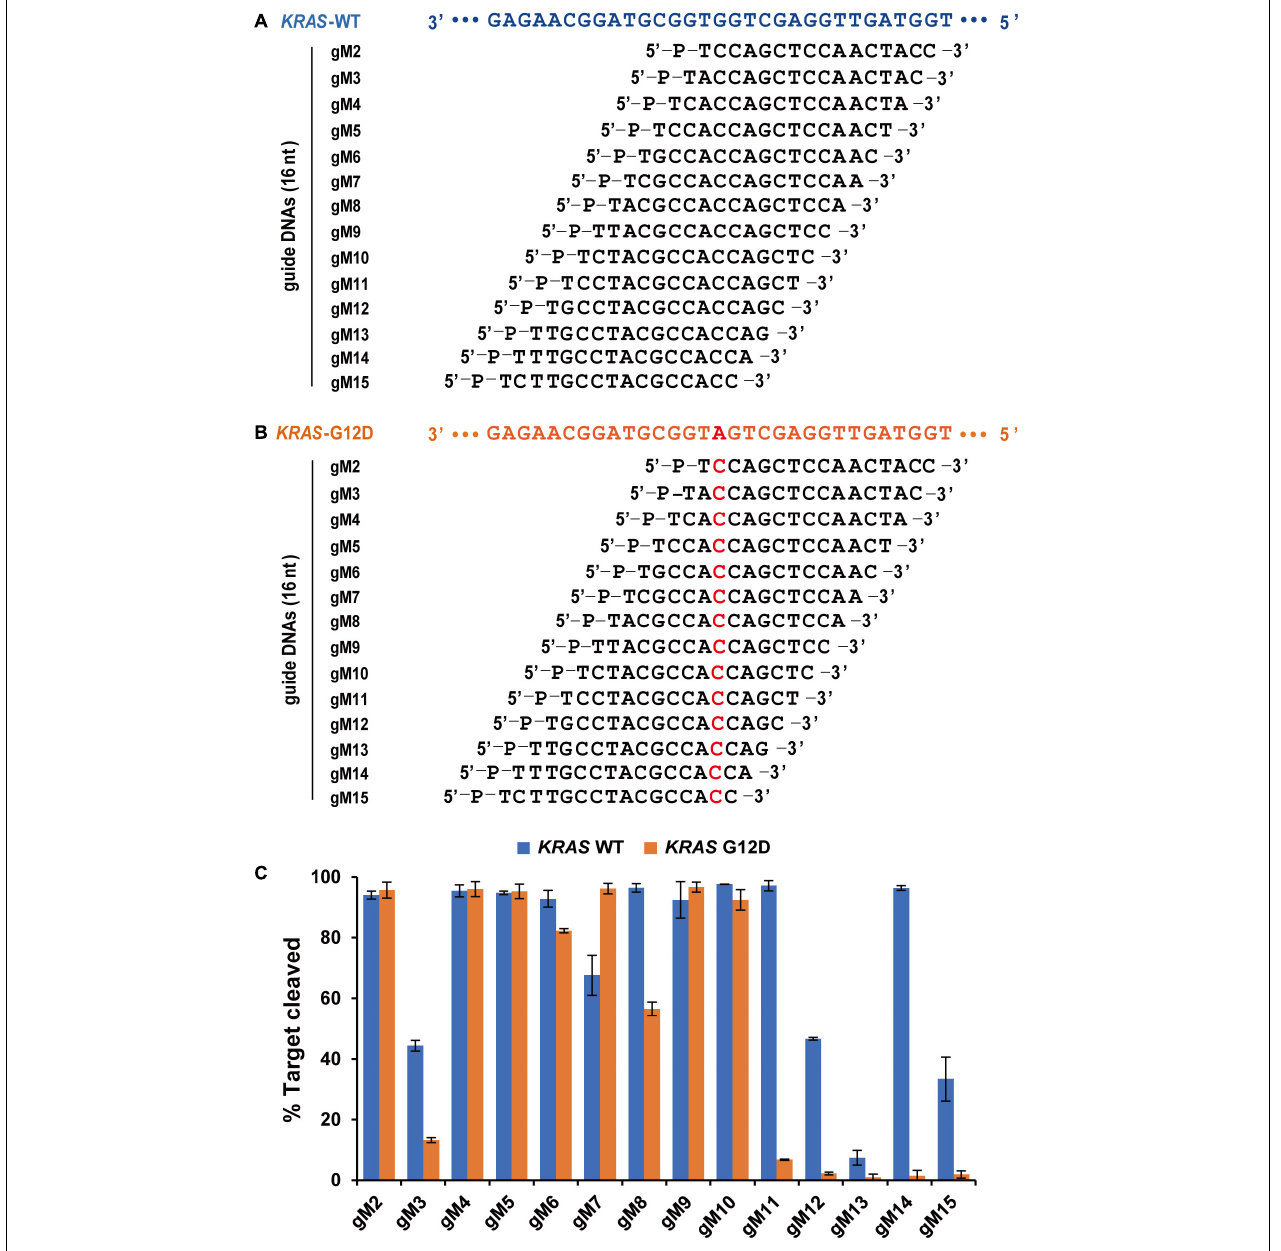
FIGURE 5 | Effects of mismatches on the cleavage activity of Fp Ago. Sequences of designed guides corresponding to KRAS WT target (A) and mutant target (B) . All guides carry a base “T” as the first base based on the previous structural studies that 5 (cid:48) -end base of the guide strand does not participate in target pairing. (C) Cleavage efficiencies of WT KRAS DNA and KRAS G12D DNA mediated by guides. All cleavage experiments were carried out at the 1:5:2 molar ratio (400 nM Fp Ago: 2,000 nM guide: 800 nM target) in reaction buffer containing 0.5 mM Mg 2 + for 15 min at 95 ◦ C.